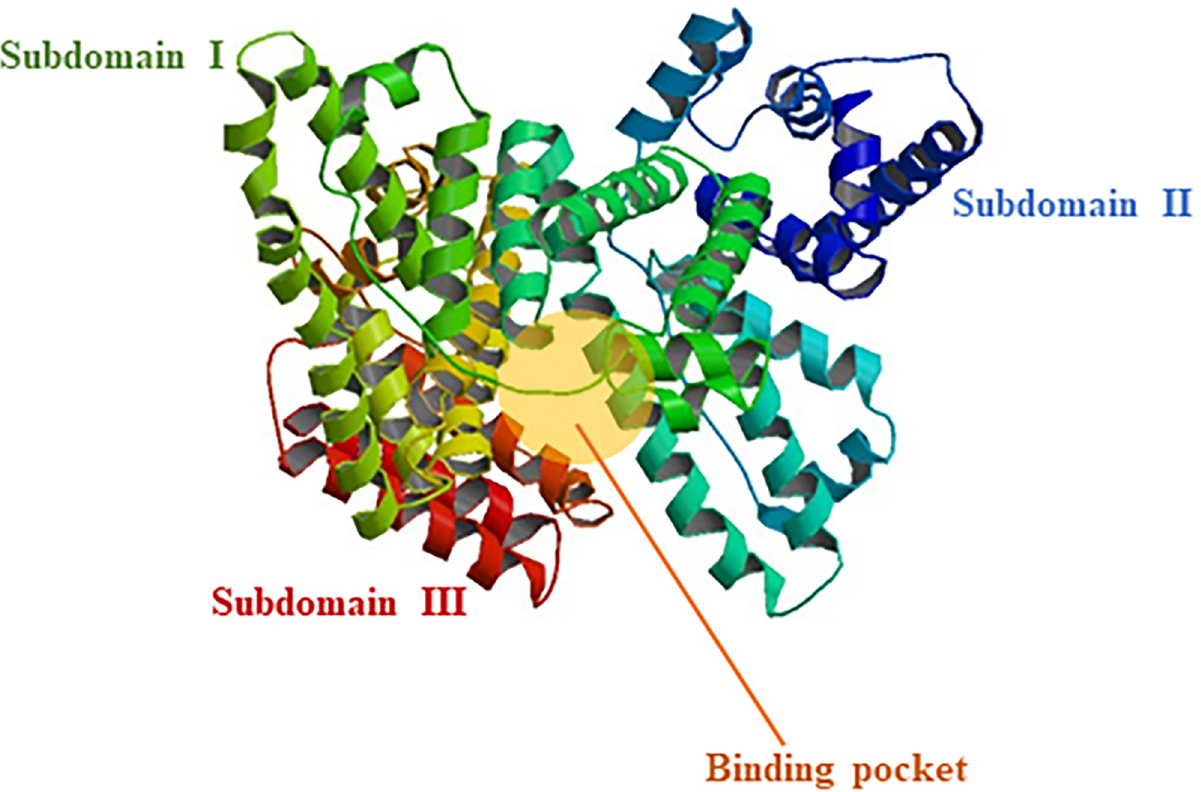
Fig 2. Structure of HSA showing subdomain I, subdomain II, subdomain III and binding pocket.